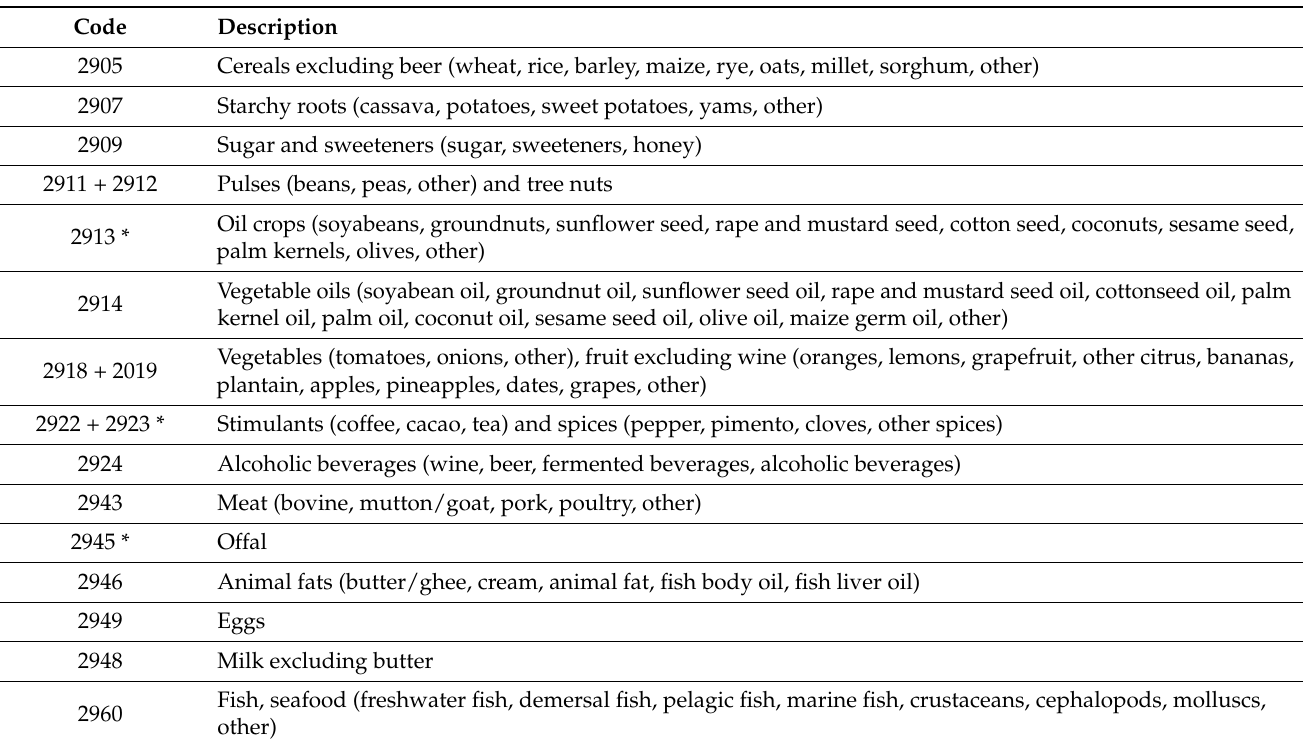
Table 1. Food intake categories and subcategories as listed in the food balance sheets for